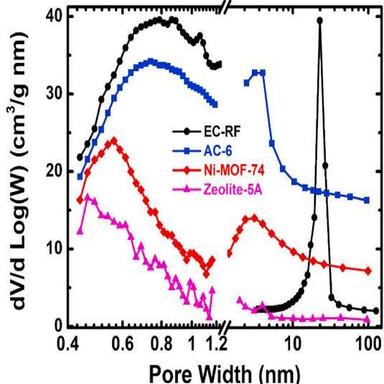
Pore size distribution from the combined micro- and mesopore regions of the samples, offset for clarity, as shown. Micropore SD (curves at 2 nm) from the BJH equation applied to the N2 sorption data at 77 K. Mesopore SD Data for EC-RF was reproduced with permission from Refs., copyright 2017 The Royal Society of Chemistry.